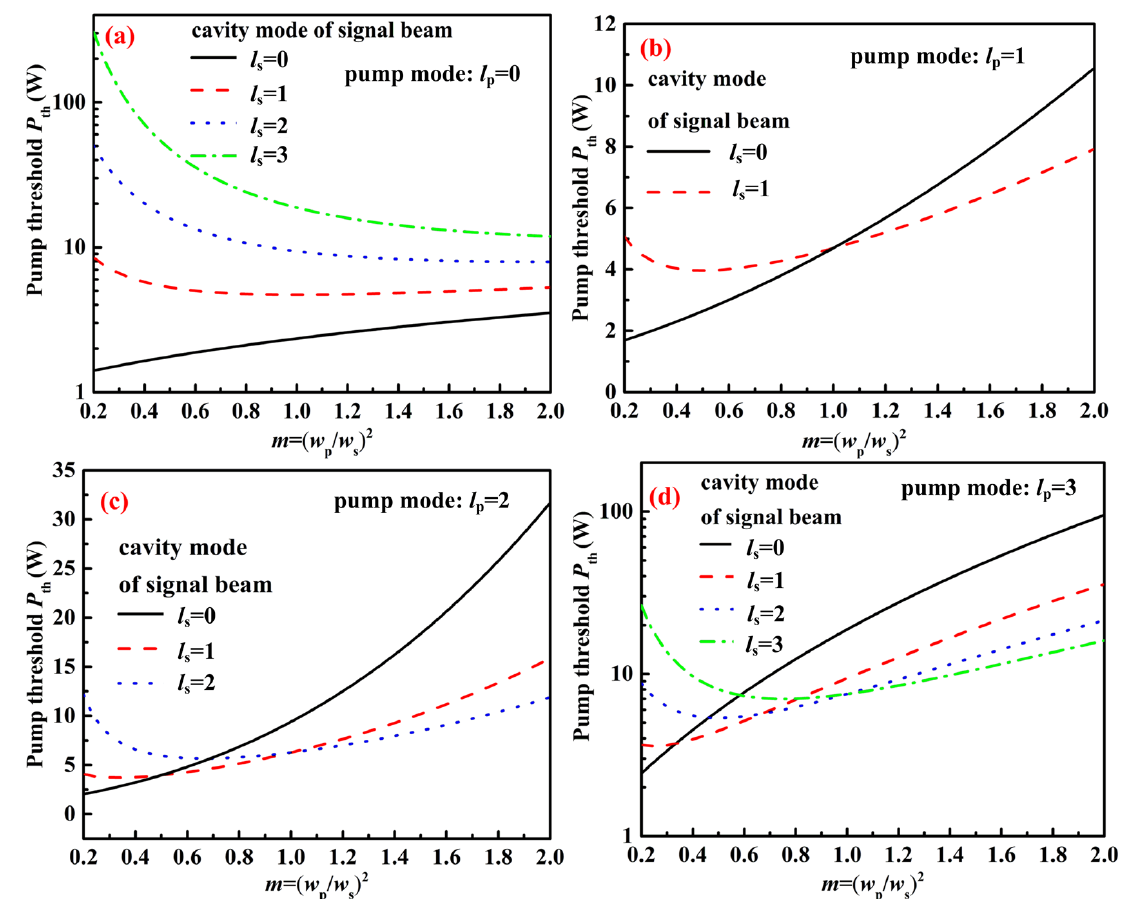
Figure 5. Theoretical predictions for the threshold of SPP-SRO versus the mode overlap ratio m for different combinations of pump vortex order l p and resonant signal vortex order l s . ( a ). l p = 0; ( b ). l p = 1; ( c ). l p = 2; ( d ). l p = 3. w s = 76 μm.